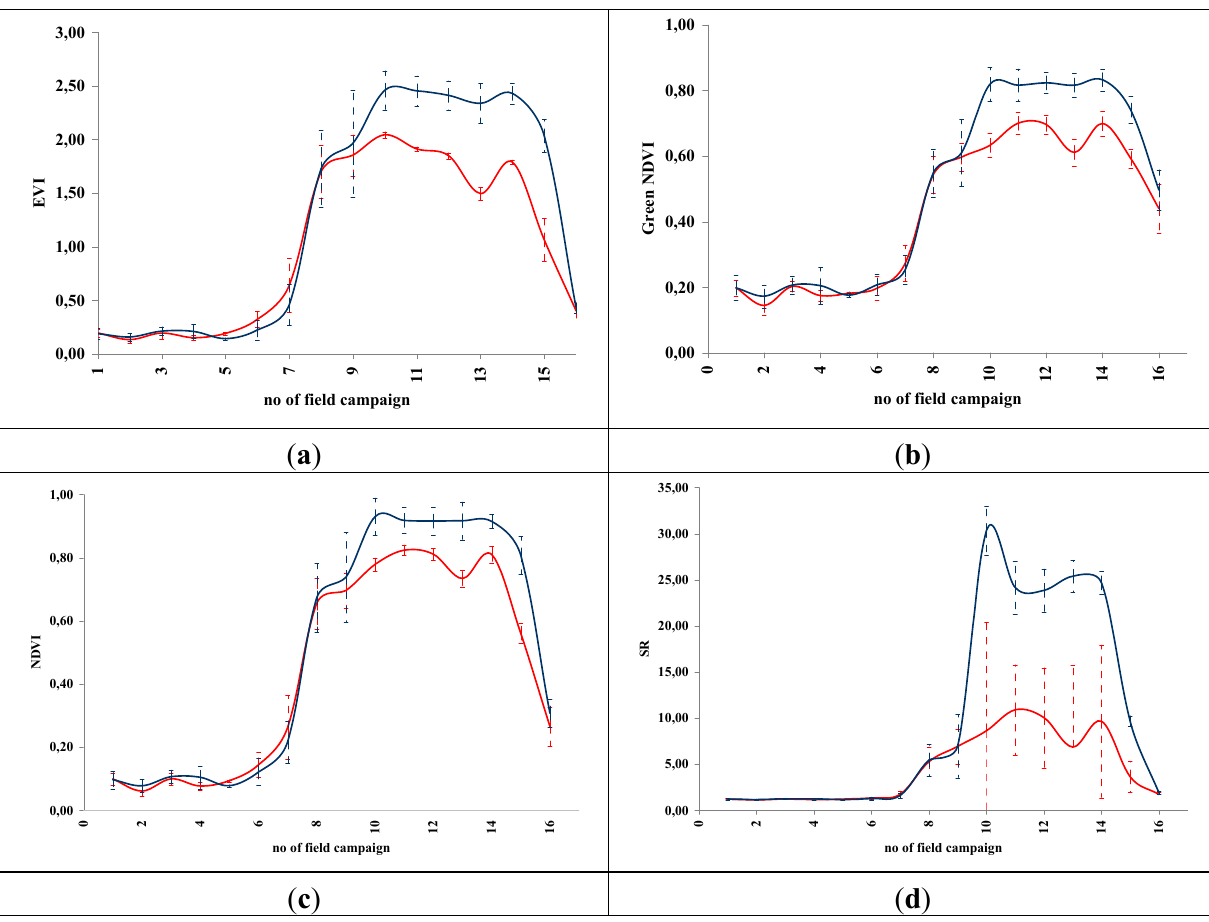
Figure 5. Broadband vegetation indices during barley crop phenological cycle (2011–2012). Healthy vegetation is indicated with a red line, while vegetation over archaeological remains is indicated with a blue line. ( a ): EVI, ( b ): Green NDVI, ( c ): NDVI, ( d ): SR, ( e ): MSR, ( f ): MTVI2, ( g ): RDVI, ( h ): IRG, ( i ): PVI, ( j ): RVI, ( k ): TSAVI, ( l ): MSAVI, ( m ): ARVI, ( n ): GEMI, ( o ): OSAVI, ( p ): DVI and ( q ): SARVI. No. of field campaign (for dates of measurement, see Section 3) is shown in X-axes, while vegetation indices values are shown in Y-axes. Dashed lines are the standard deviation